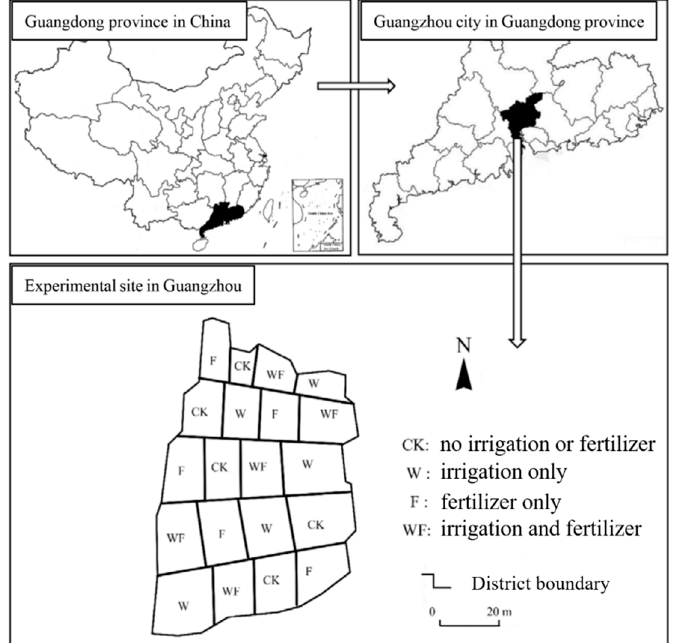
Figure 1. Study area with four treatments, was located in Guangzhou City in Guangdong Province,